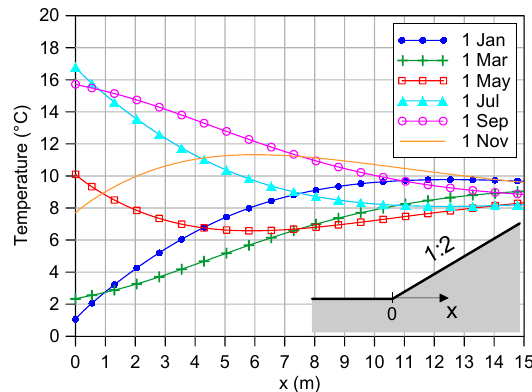
Figure 17. Horizontal temperature gradient at the base of a 1:2 slope. Finite element solutions for average (solid line) and low (dashed lines) thermal conductivity of the embankment